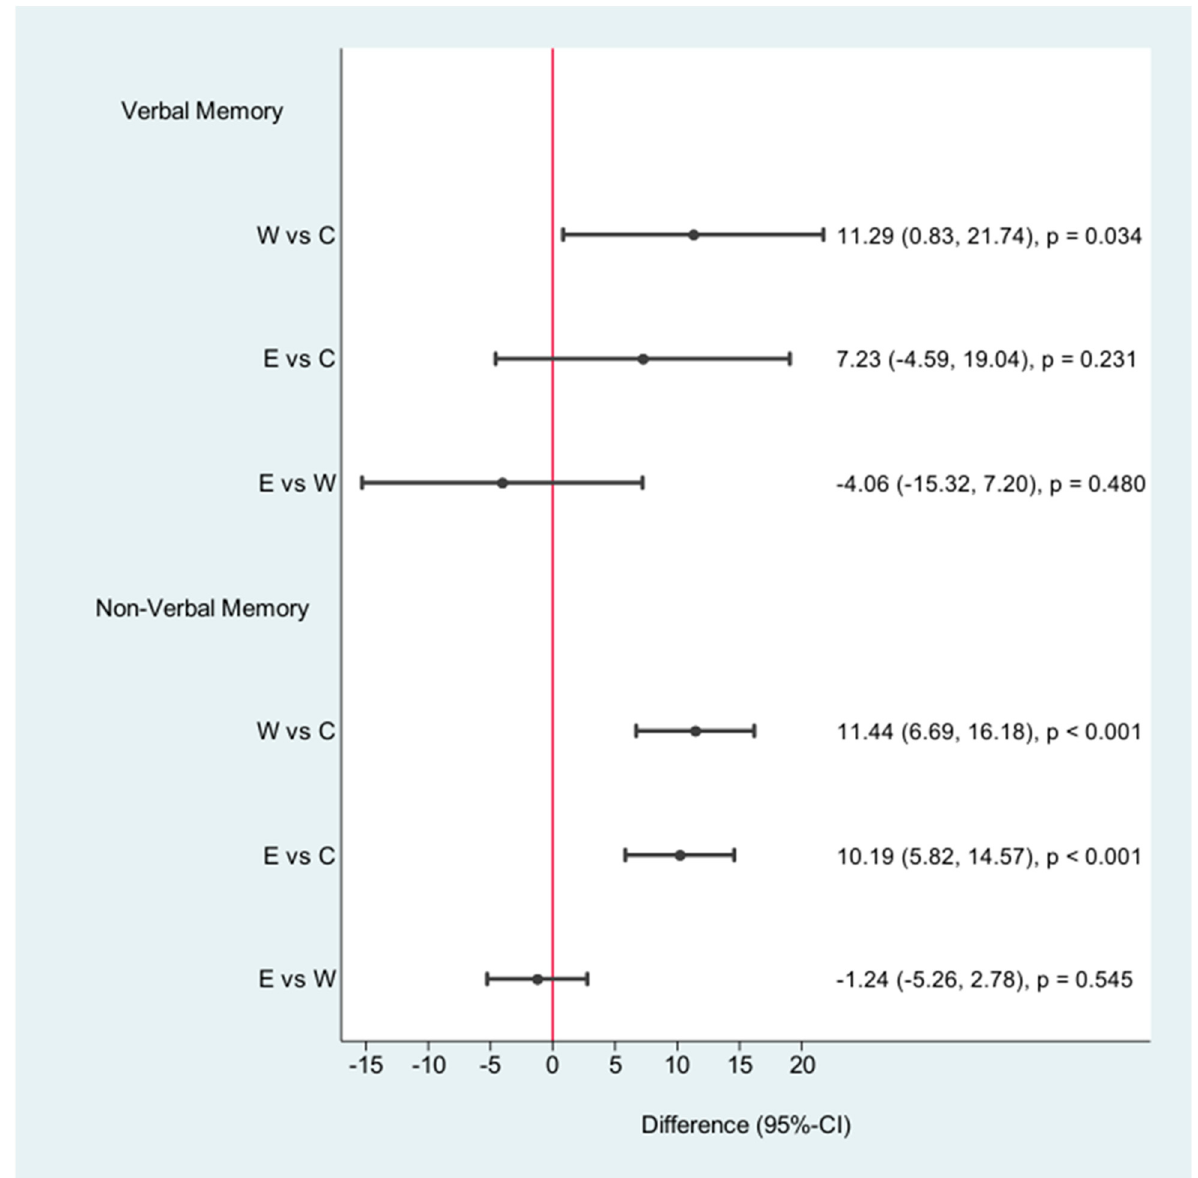
Figure 4. Cognition: differences after the intervention; W = walking, C = control, E = E-health.